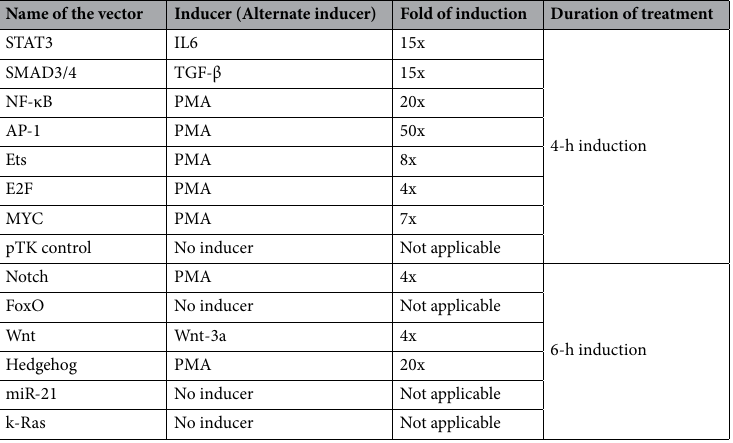
Table 5. The panel of 13 inducible luciferase reporter gene vectors where expression is driven by enhancer elements (Inducer) that bind to specific transcription